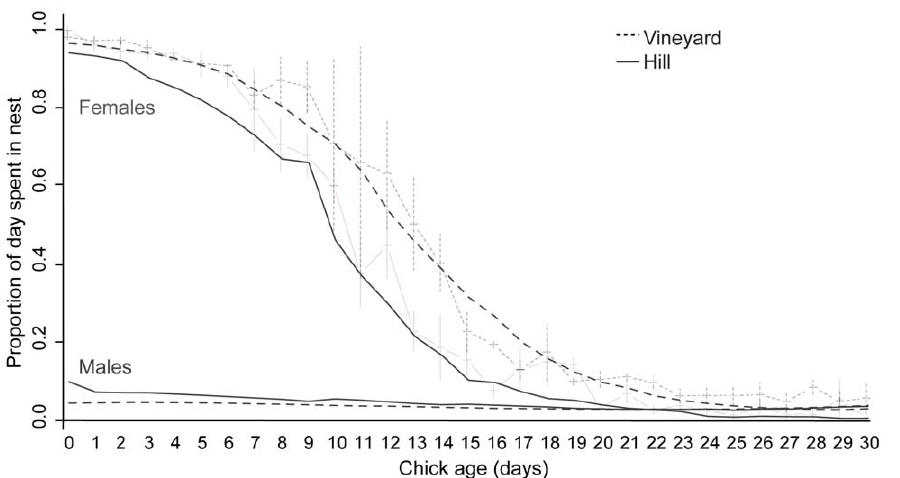
Figure 3. Proportion of the day that both adult falcons were in attendance at the nest as chick age increased in vineyard (dotted lines) and hill (solid lines) nests. Thin grey lines show the raw data for both parents combined, with + SEM for vineyard nests and the data mean – SEM for hill nests. Thick lines show the fitted values from a GLMM including significant second and third order polynomial terms for female falcons (black lines) and from a GLMM including significant second order polynomial terms for male falcons (dark grey lines).